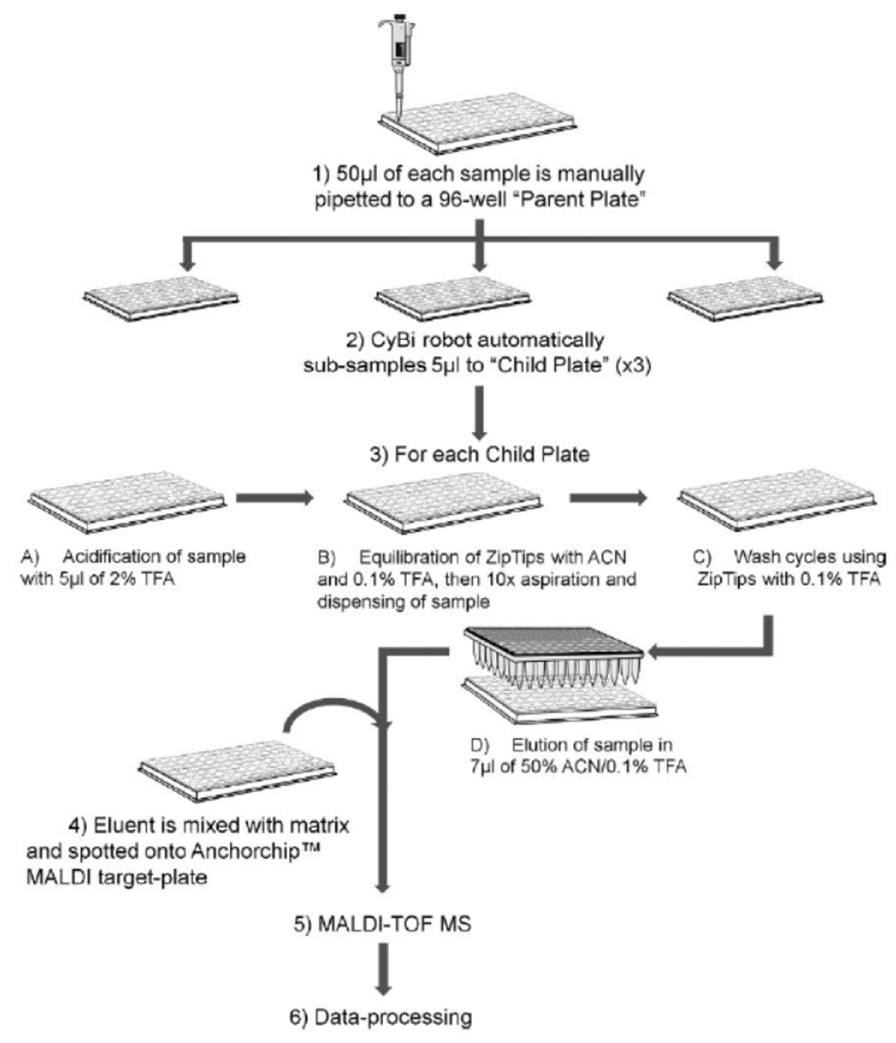
Figure 2. Schematic of the automated workflow adopted in [36]. Reprinted with permission from Ref. [36]. Copyright 2014 John Wiley and Sons.